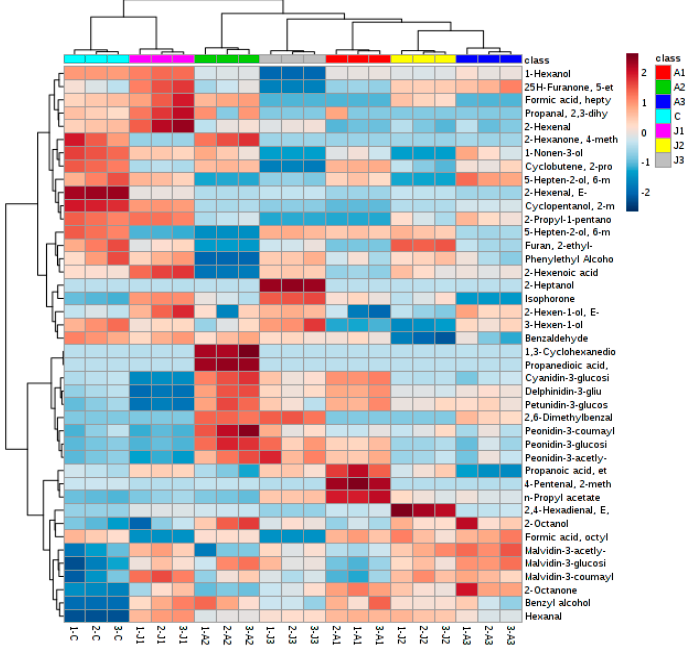
Figure 1. Heat map of anthocyanins and volatile aromas after different treatments. A1: treatment with 1000 mg·L − 1 ABA; A2: treatment with 600 mg·L − 1 ABA; A3: treatment with 200 mg·L − 1 ABA; J1: treatment with 800 µmol·L − 1 MeJA; J2: treatment with 200 µmol·L − 1 MeJA; J3: treatment with 50 µmol·L − 1 MeJA; C: control. Values are the mean of three replicates (±standard deviation). The heat map graphic distances were measured using Euclidean distances, and the clustering algorithm using ward dendrogram. Each colored cell on the map corresponds to a concentration value (normalized to the control sample).